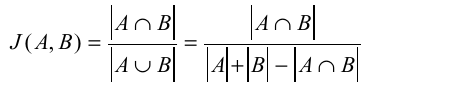
Table 2. An example of a movie-movie similarity